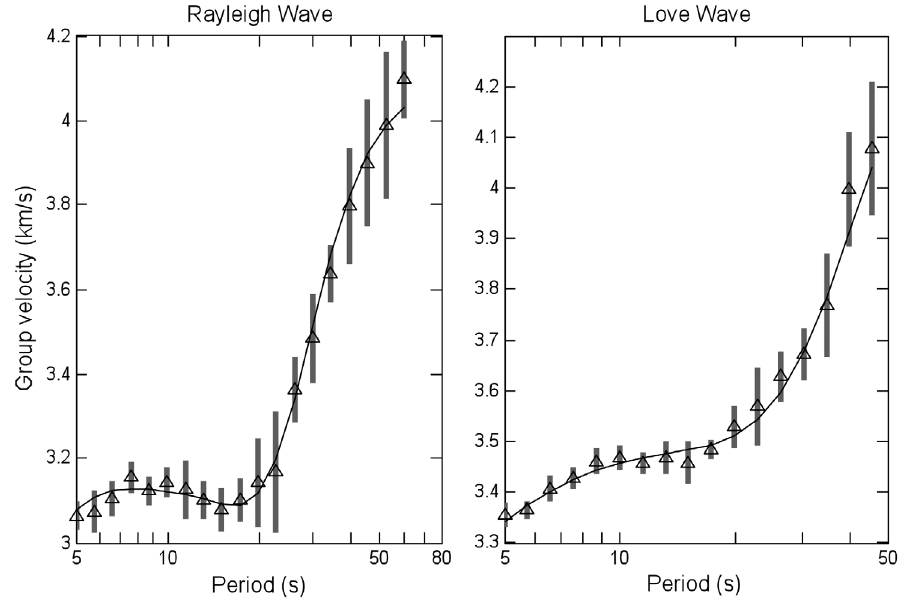
Figure 5. Observed mean group velocity data (open triangles) with ± one standard deviation. The theoretical curve has been drawn for the structure of central DVP (Table